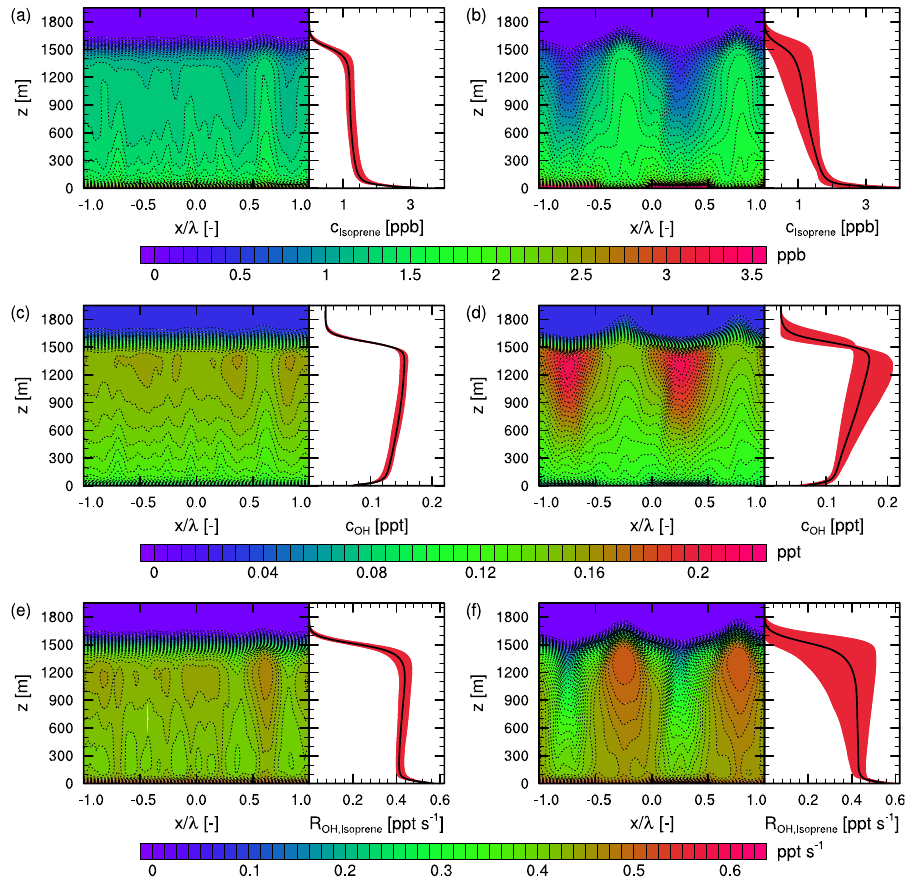
Fig. 4. Isoprene and OH concentrations and chemical reaction rates for the homogeneous case (a, c, e) and the heterogeneous case (b, d, f) . Each figure consists of two panels. The first panel shows these variables averaged over the fourth hour of simulated time and the y-direction, while the second panel shows an additional average in the x-direction. The red area in the second panel shows the variability in the x-direction of the temporal and y averaged values. The concentration of Isoprene, c Isoprene , is shown on top (a, b) , followed by the concentration of the hydroxyl radical, c OH , in the middle (c, d) . At the bottom (e, f) the chemical reaction rates for Reaction (R9), R OH , Isoprene , are displayed. The x-coordinate is scaled by the length scale of heterogeneity, λ , which is twice the patch